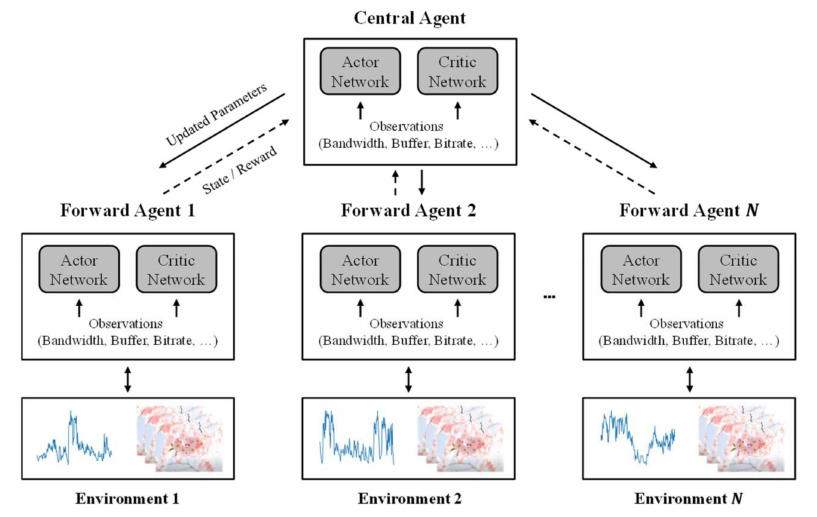
Figure 4. Multi-agent training process used to train the neural network